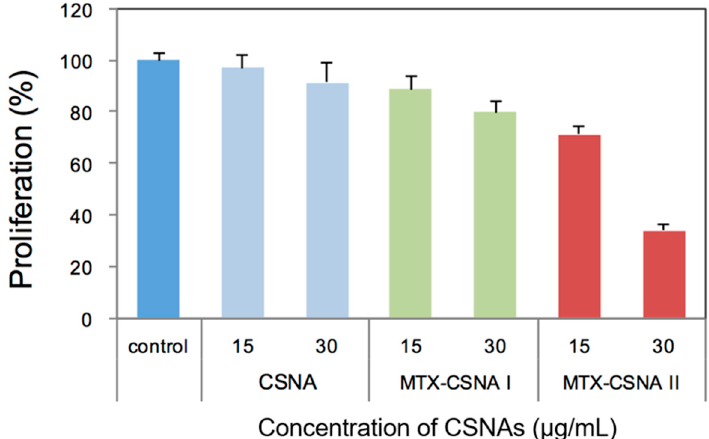
Figure 6. Cytotoxicity evaluation of MTX-CSNAs. XTT assay of CSNA, MTX-CSNA I (EDC/NHS coupling-based), and MTX-CSNA II (CPy-based). MTX-CSNA II showed substantial cytotoxicity over the other samples, reflecting the fact that the MTX molecules are well-coated onto CSNAs via the CPy-based functionalization method.